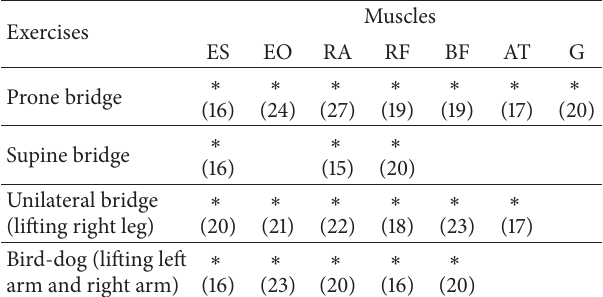
Figure 7: The MF and its one-order fitting for RF, BF, AT, and G muscles in the exercise of prone bridge.